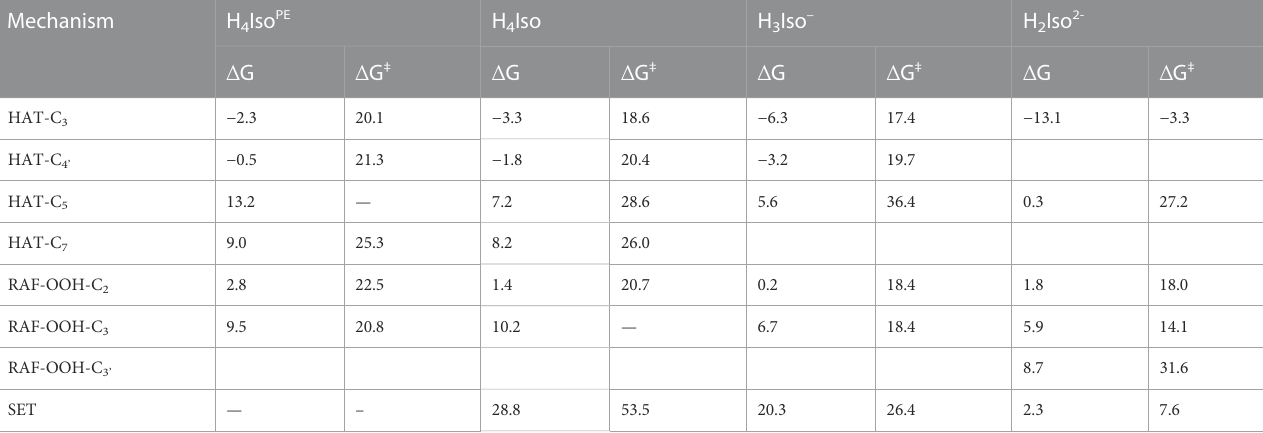
TABLE 2 Gibbs free energies of reaction ( Δ G) and activation ( Δ G ‡ ) at 298.15 K in aqueous solution and pentylethanoate (indicated by PE apex) for neutral and charged isorhamnetin species. All values are in kcal/mol. Mechanism